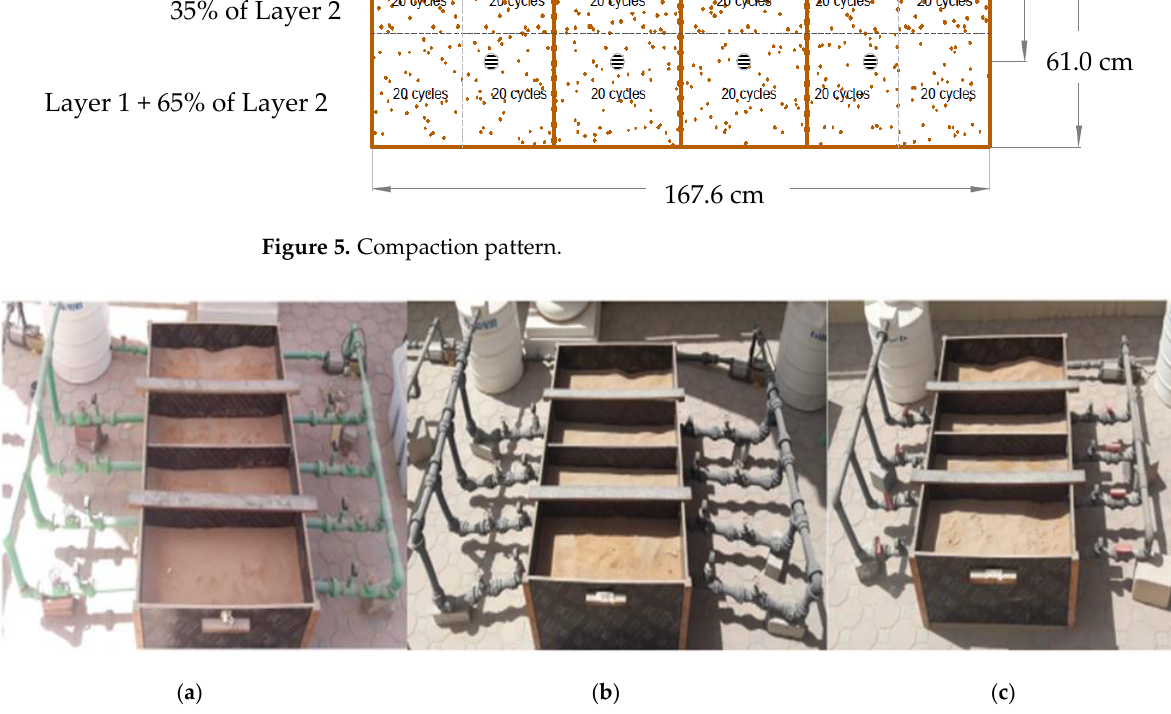
Figure 6. Setups compacted with dune sand: ( a ) PPR, ( b ) PE, and ( c ) PVC.